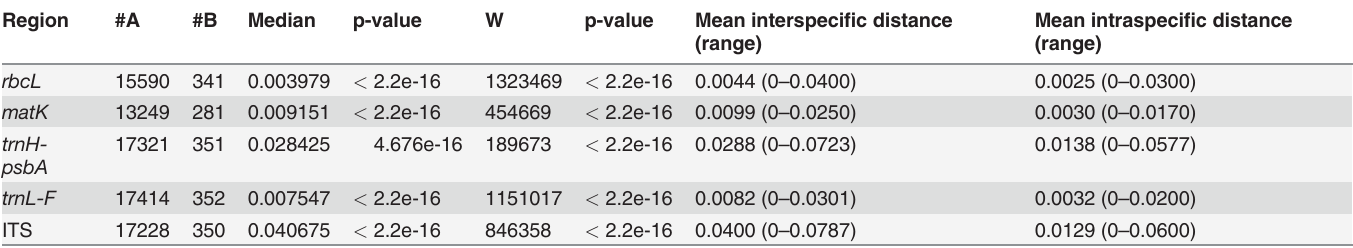
Table 4. Results of the median and the Wilcoxon two-sample tests based on interspeci fi c versus intraspeci fi c Kimura 2-parameter distances for each barcode. Region